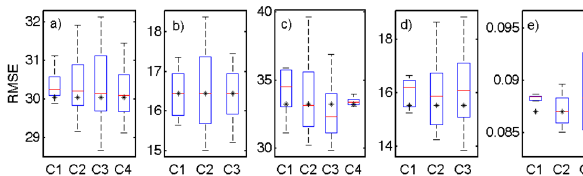
Figure 13. Boxplot of RMSE’s of the sensitivity analysis made for (a) Q H in Ku (Wm − 2 ) , (b) Q E in Ku (Wm − 2 ) , (c) Q H in Rl (Wm − 2 ) , (d) Q E in Rl (Wm − 2 ) and (e) runoff in Pi (mmh − 2 ) . The sensitivity are to changes in: the power in the depletion curve (Eq. 15a) (C1), S WE,Lim (C2), meltwater coefficients ( a r ,a t ) (C3) and storage heat flux coefficients ( a 2 , a 3 ) (C4). The final model values are indicated (*). For other details see